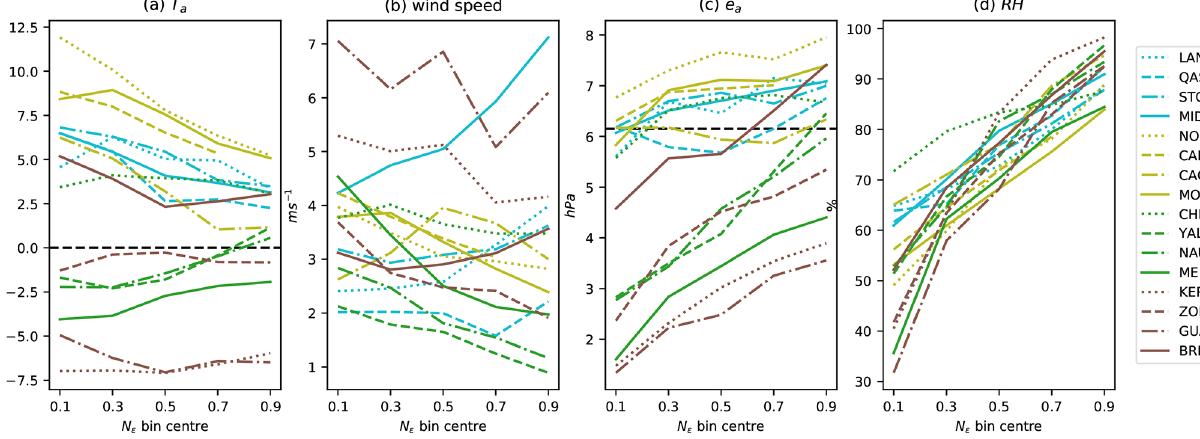
Figure 8. Average melt-season near-surface meteorology for different daily average cloud conditions ( Nε ). Dashed lines indicate melting point temperature in (a) and saturation vapour pressure in (c)